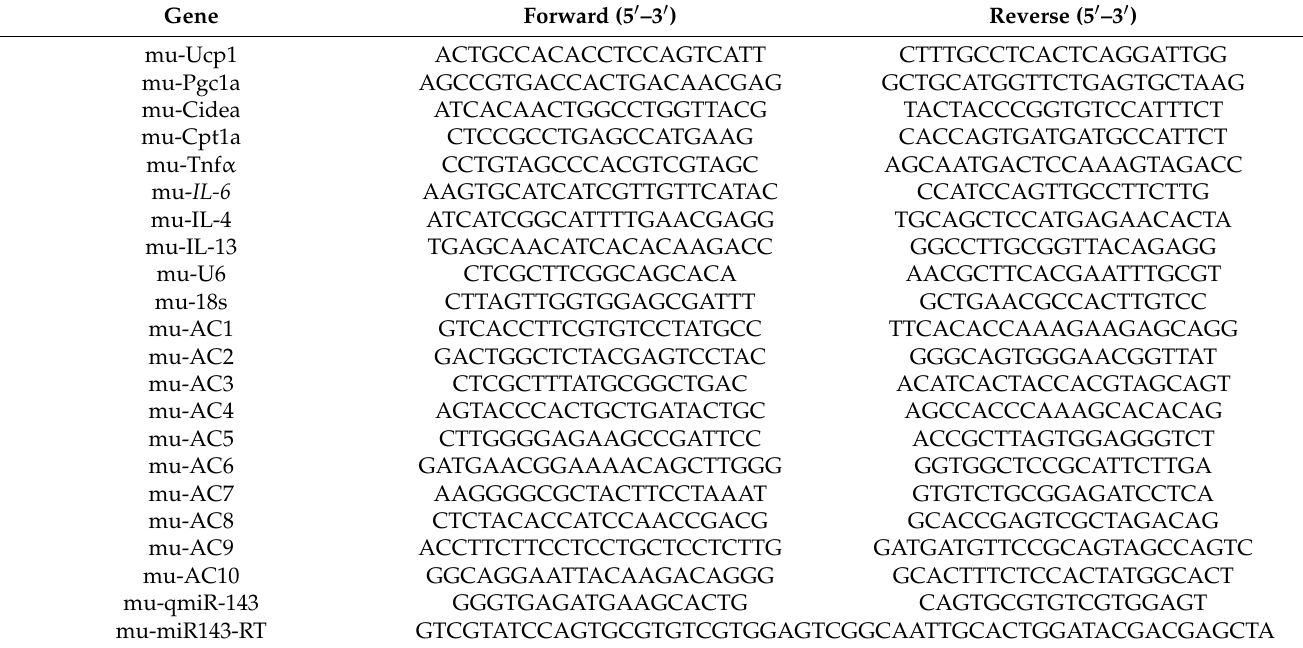
Table 1. Primer sequences for quantitative real-time